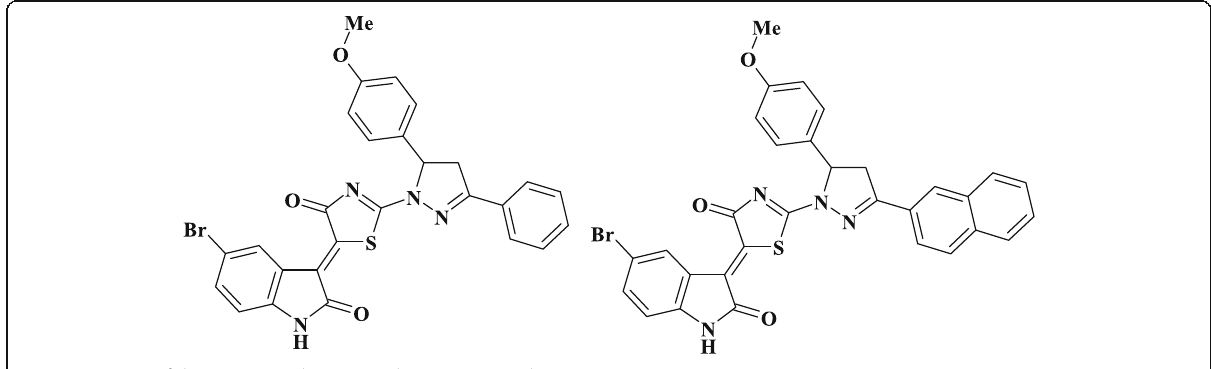
Fig. 1 Structure of the investigated compounds — Les-3288 and Les-3833